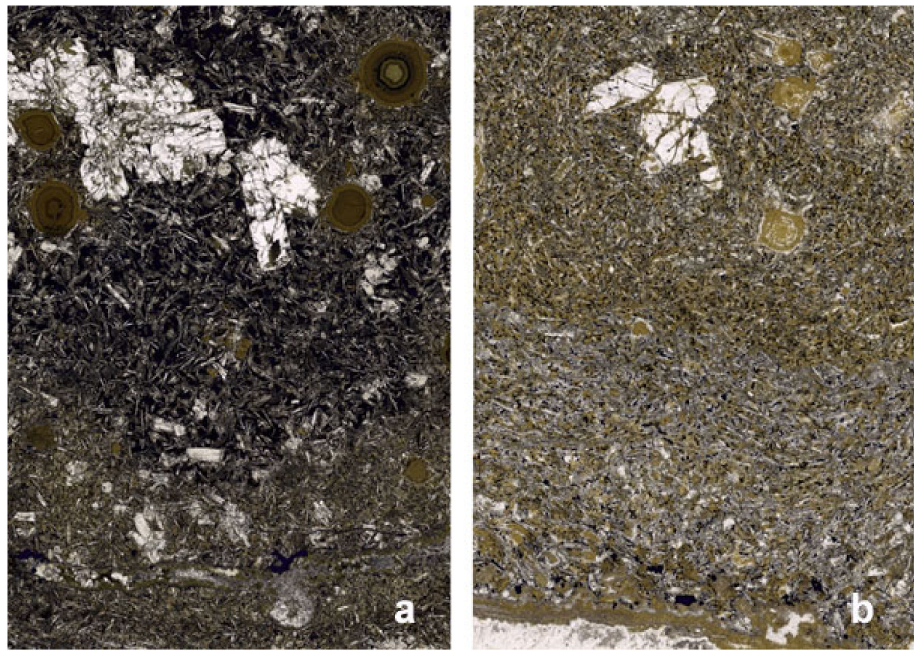
Figure 5. Thin section of pillow basalt. ( a ) Fresh basalt (dark upper part) with aggregate of plagioclase phenocrysts and altered basalt (lower part) (sample K1, field of view (fov) ca. 7 mm). ( b ) Altered basalt (upper part) and spilitized basalt (lower part). At the bottom, the margin of a cavity consisting of laumontite, calcite, and other minerals is visible (sample K2, fov ca. 3.5